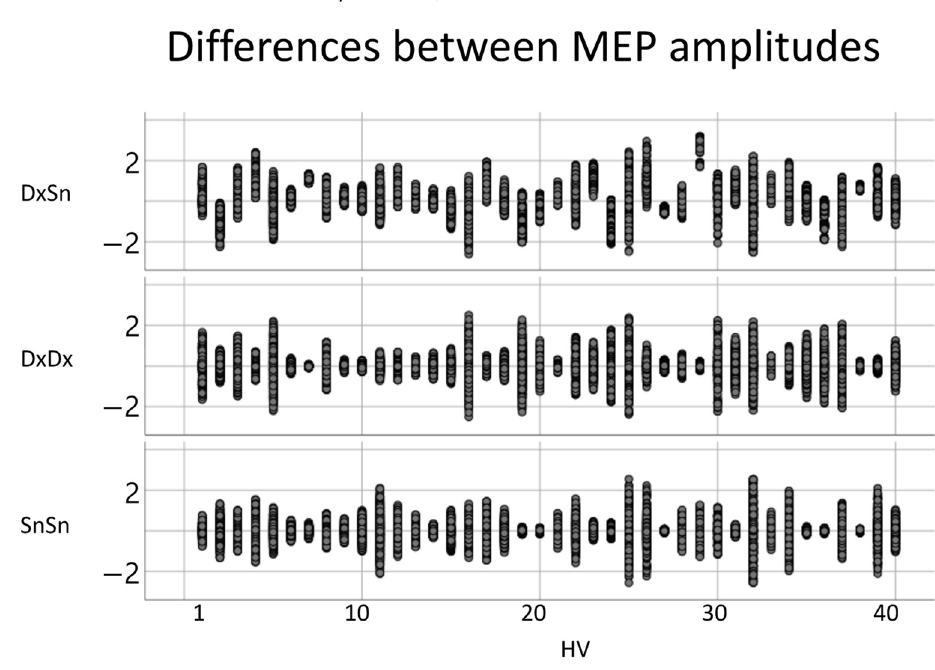
Figure 4. Inter-side and intra-side MEP amplitudes. For each healthy volunteer (HV), the difference between each pair of MEP amplitudes for left-right comparison (first row) and intra-side comparison (right side, second row; left third row).